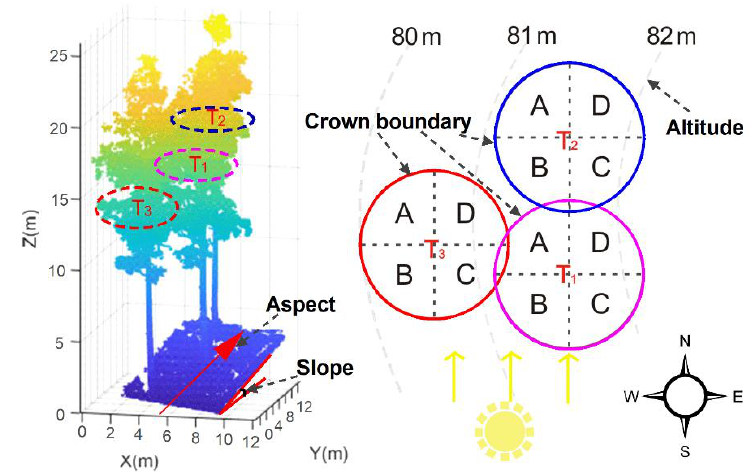
Figure 10. Schematic diagram of sample plot forest competition.